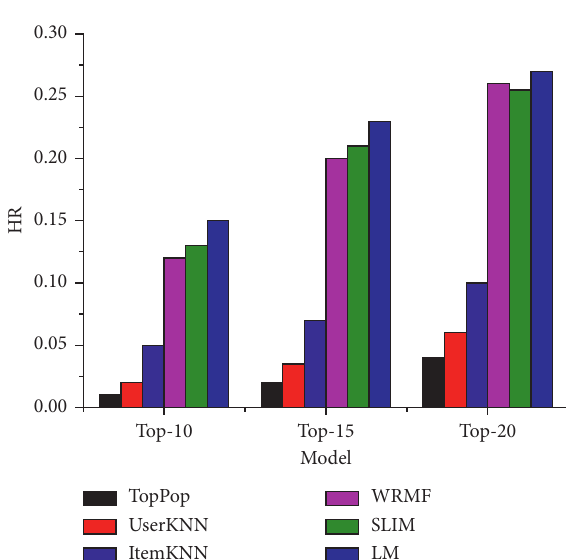
Figure 9: The contrast experiment of the HR index.